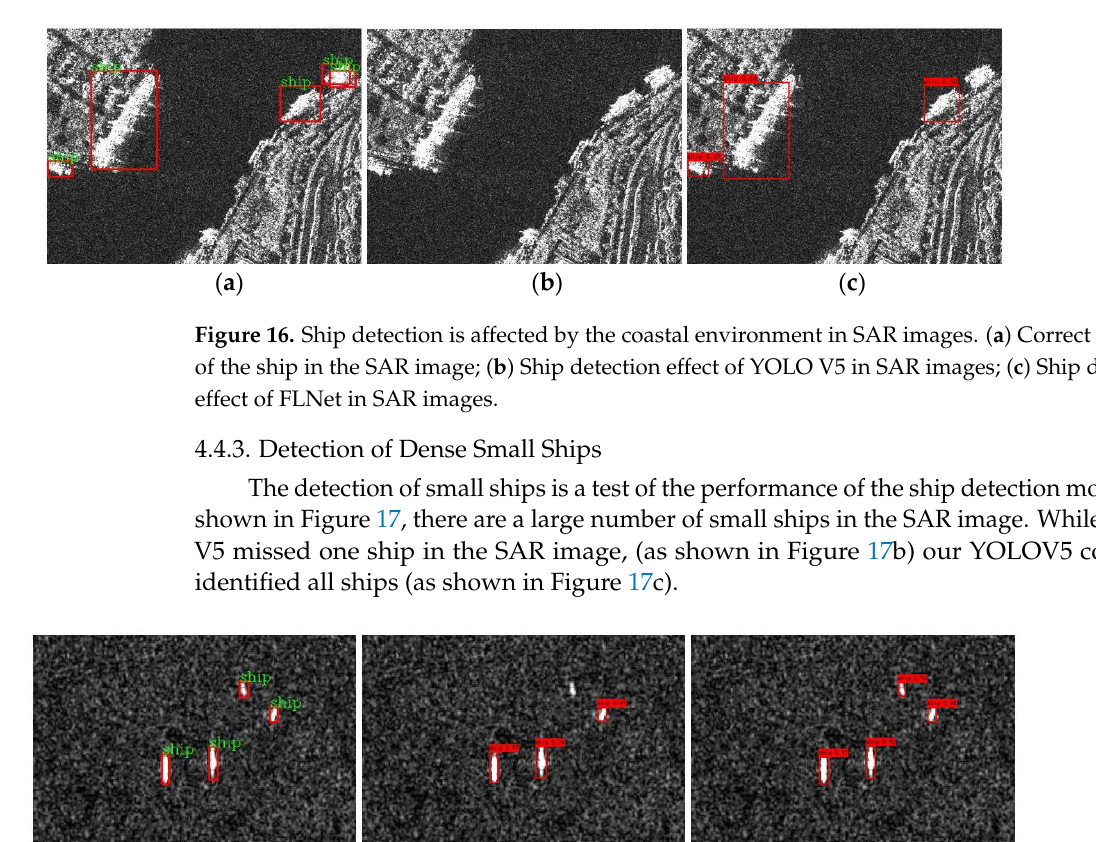
14 of 20 Table 3. Experimental results on HRSID dataset. Model